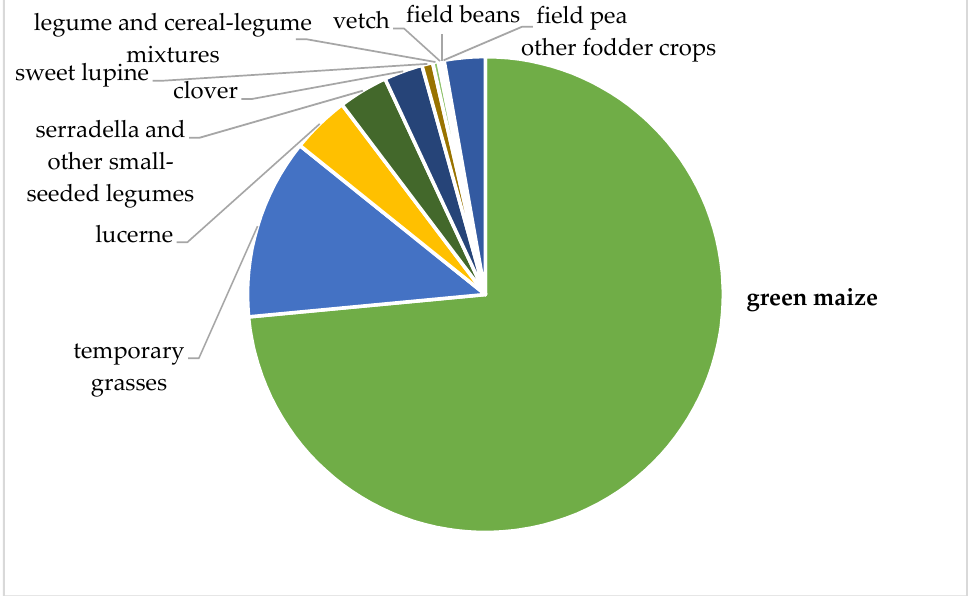
Figure 2. Structure of field green fodder crops production (Total production of field green fodder crops = 100. Source: own elaboration based on [36].